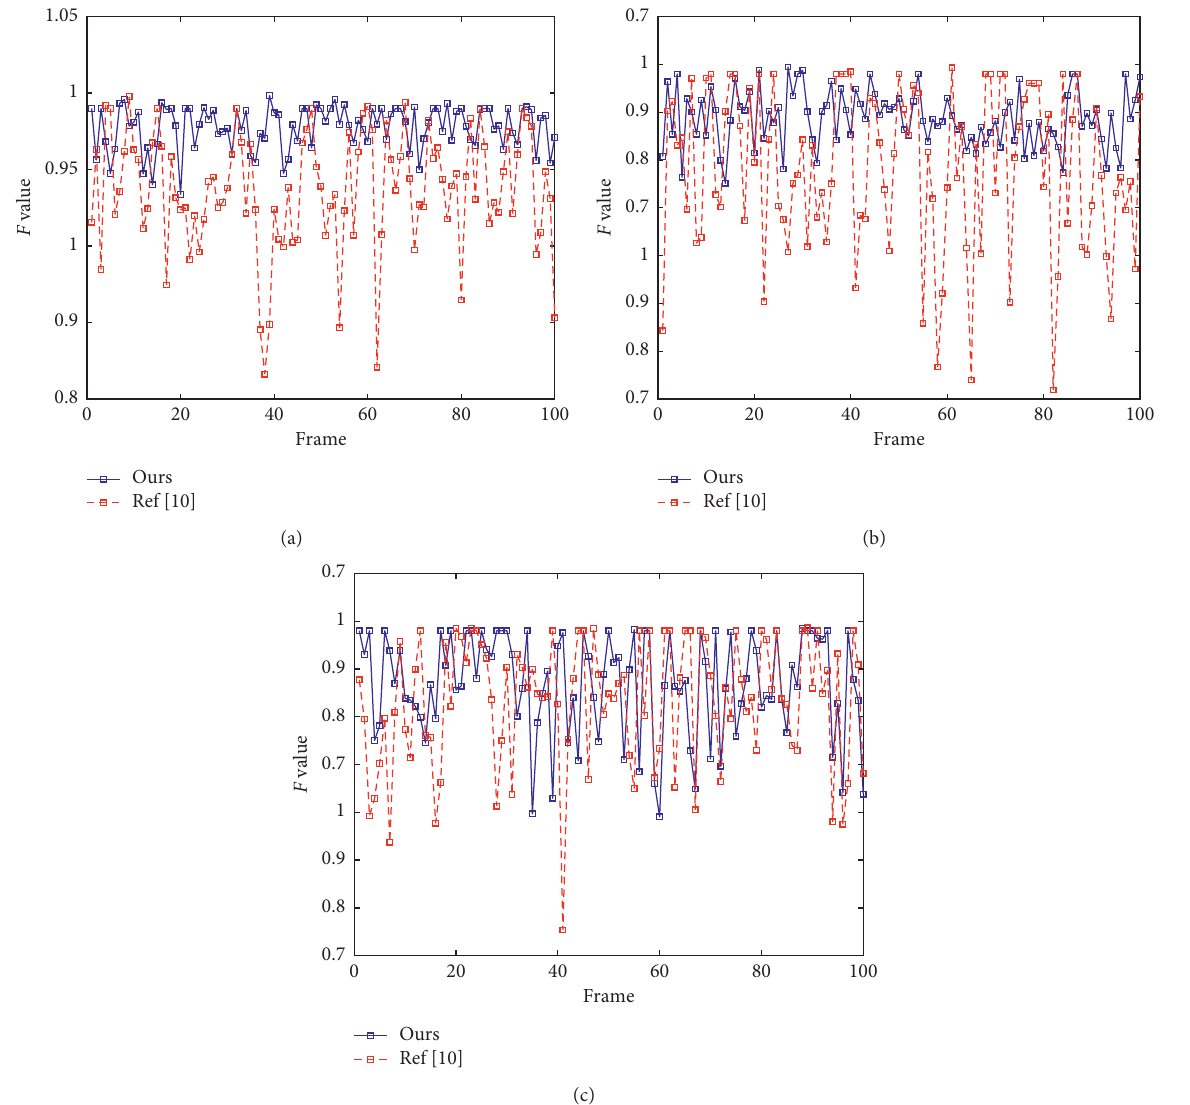
Figure 10: Comprehensive evaluation index F curve comparison of three datasets. (a) F value comparison of Enpeda dataset. (b) F value comparison of KITTI dataset. (c) F value comparison of Daimler dataset.